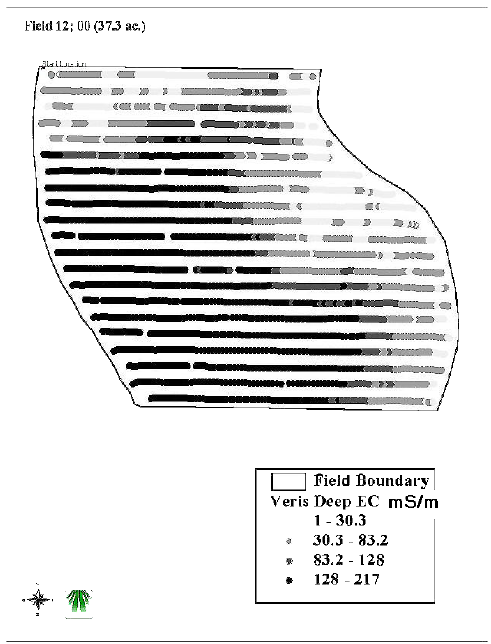
FIGURE 16. Soil EC data from a 15-ha Louisiana